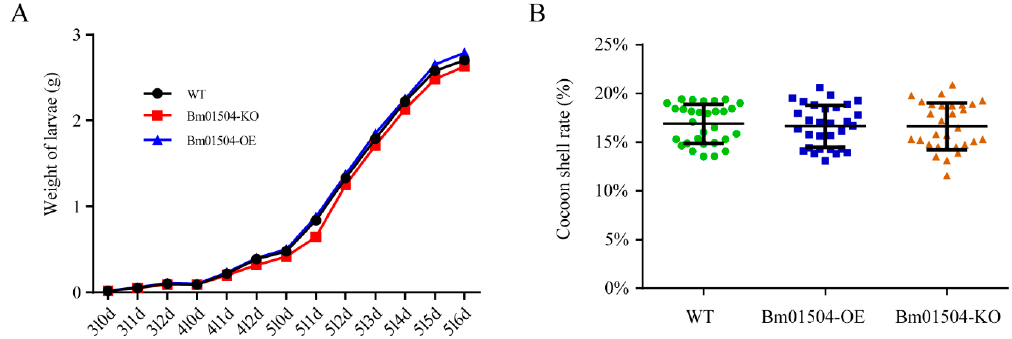
Figure 6. Economic characteristics of Bm01504-KO, Bm01504-OE, and WT. ( A ) Weight changes in the transgenic lines and WT from the third instar to 6th day of the fifth instar. The average weight of 30 larvae per group is shown. 3l, Third instar of larval stage; 4l, Fourth instar of larval stage; 5l, Fifth instar of larval stage; nd, Day n; ( B ) analysis of the cocoon shell rate of the transgenic lines and WT at pupal stage. Thirty cocoons of each silkworm strain were randomly selected on 3rd day in the pupal stage, and the cocoon shell rate was calculated. Each value represents the average of three repeated measurements. The experiments were repeated thrice.